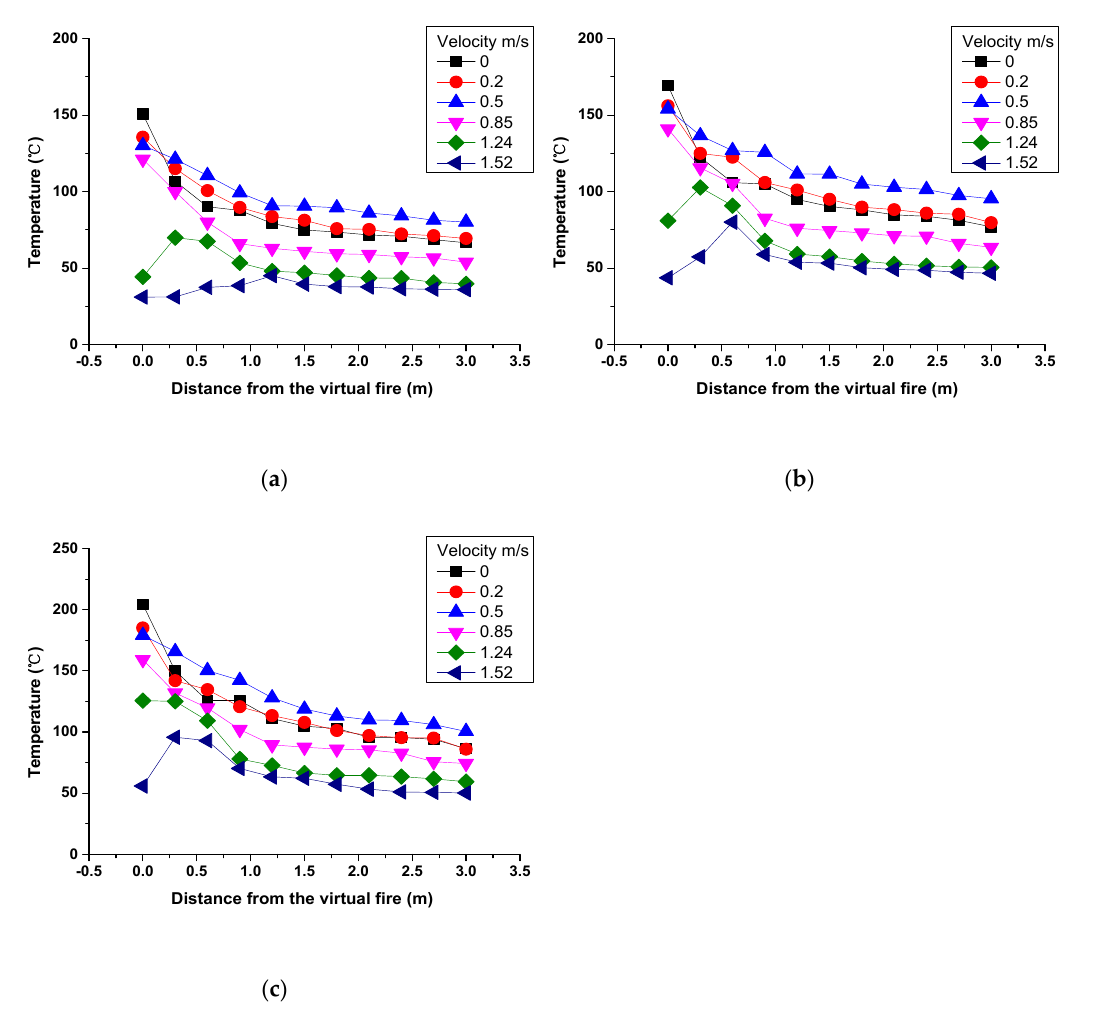
Figure 8. The ceiling temperature distribution for the corridor open to the environment: ( a ) HRR of 10 kW; ( b ) HRR of 15 kW; ( c ) HRR of 20 kW.